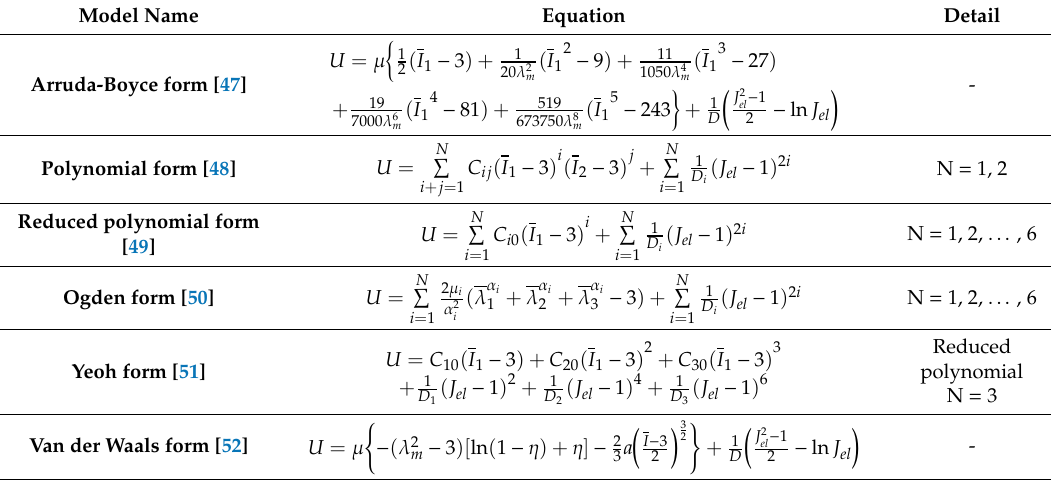
Table 1. The strain energy potential models used in the simulation of Bis-GMA polymer under monotonic compressive